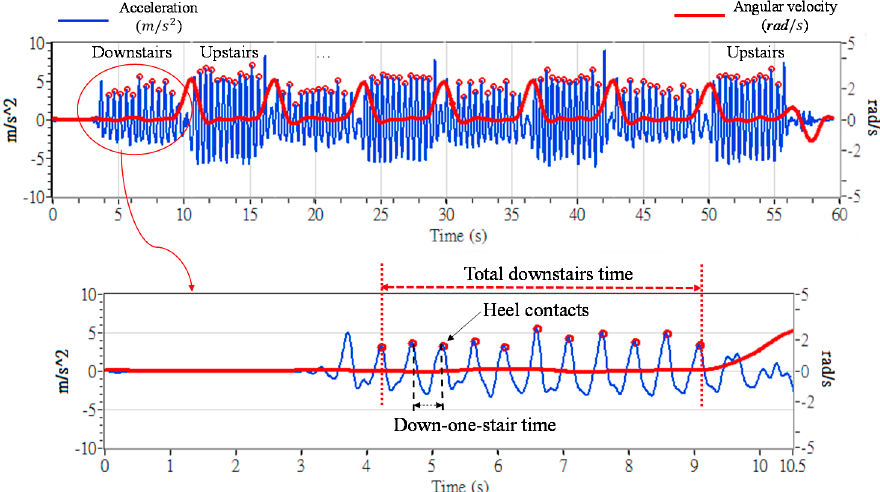
Figure 4. Upstairs and downstairs signals. The horizontal line represents time (s), the left vertical line shows the acceleration (m/s 2 ), and the right vertical line shows the angular velocity (rad/s), respectively along and about the X -axis of the tracker.